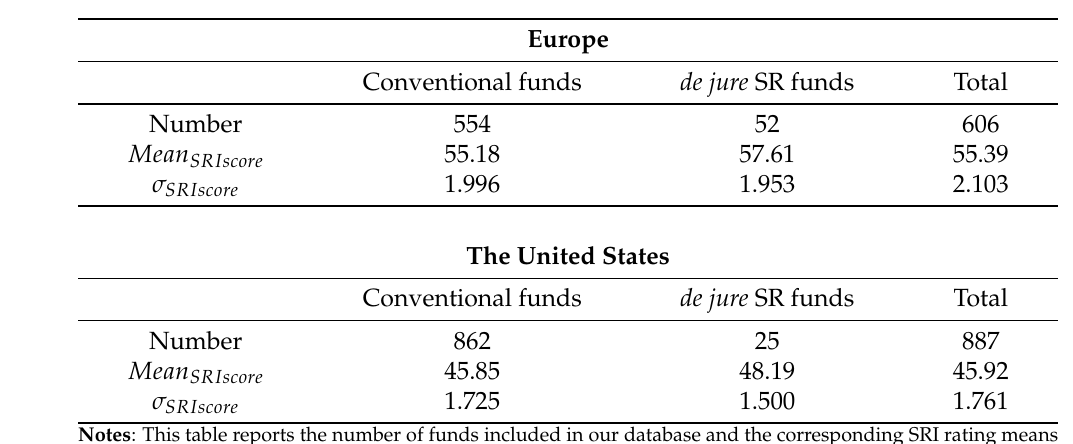
Table 2. Europe/US–Descriptive Statistics–Conventional vs. de jure socially responsible (SR) mutual